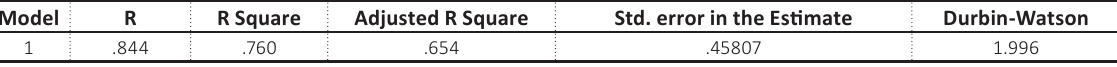
Table 5. ANOVA results